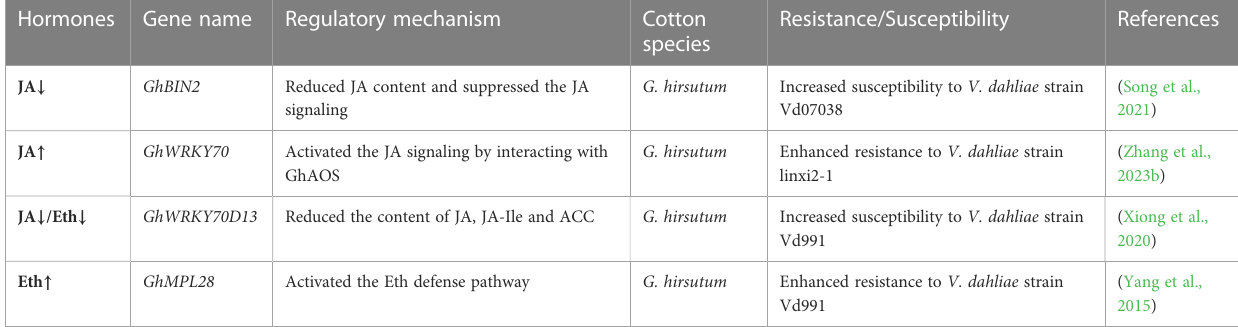
Upward arrows represent the positive regulation of hormone signaling by genes, while downward arrows represent the negative regulation of hormone signaling by